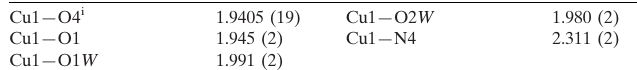
Selected geometric parameters (A˚ , (cid:3) ).